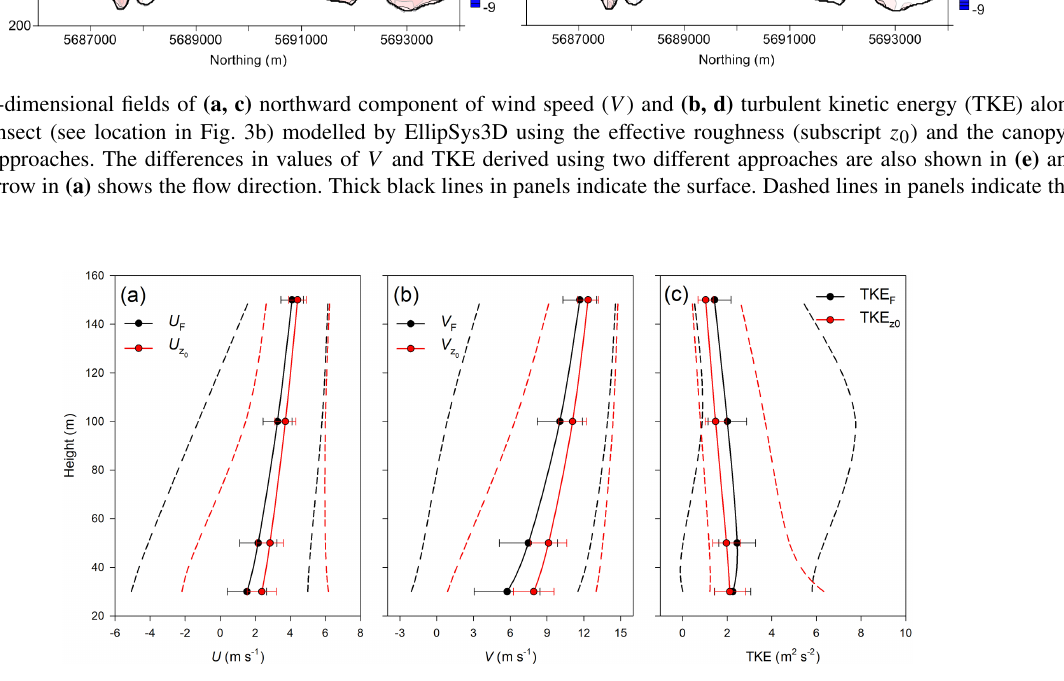
Figure 9. Average values of (a) eastward ( U ), and (b) northward ( V ) components of wind speed and (c) turbulent kinetic energy (TKE) in the area of interest at different heights over ground (30, 50, 100 and 150m) derived using the canopy drag (black) and the effective roughness (red) approaches. Bars denote standard deviations. Range of variables is indicated by dashed